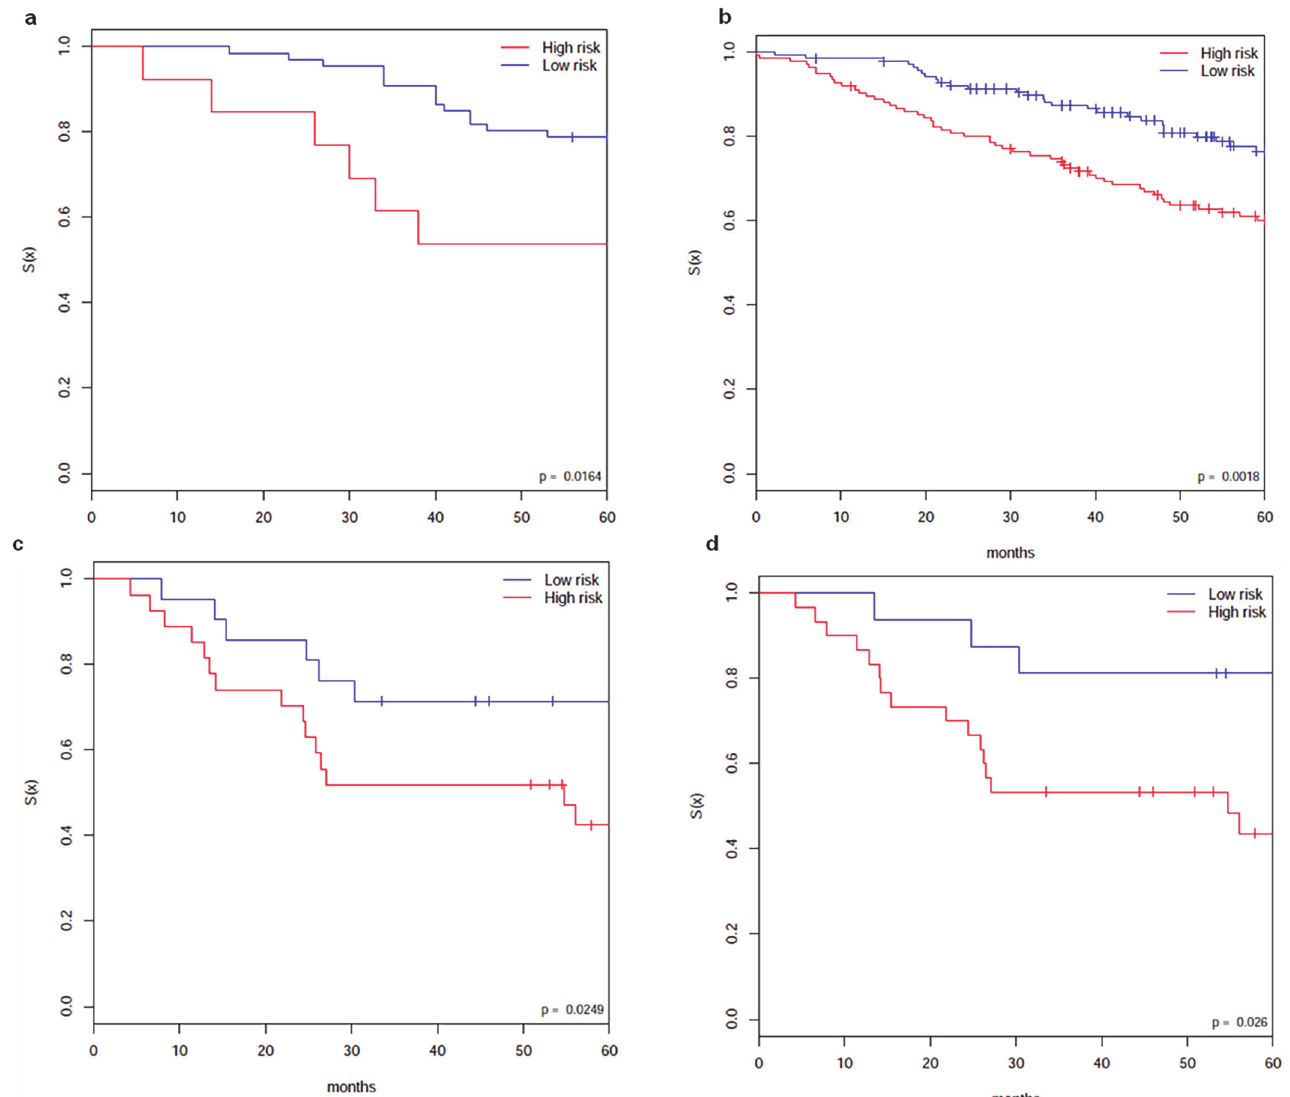
Fig 6. Clustering of stage I samples. (a) and (b). Kaplan-Meier plots of the consistent clustering of ACC stage1 (a) and that of Jacob stage1 (b) from our clustering approach. The clusters identified by our clustering approach show statistically significant survival differences. (c) and (d). Comparison of the sample separation based on the 144 identified genes and the separation based on the stage information of the GSE5843 dataset. (c) Independent verification testing of the 144 identified genes on GSE5843. Kaplan-Meier plots of the clusters of the samples, which shows statistically significant survival differences. The clusters is from MBI running with parameter k 2 = 2 on the corresponding rows of the dataset (i.e., using only the part of Y matrix of GSE5843 that corresponds to the 144 genes). p-value = 0.0249. (d) Kaplan-Meier plots of the clusters of the samples based on the separation of stage IA and IB. p- value =